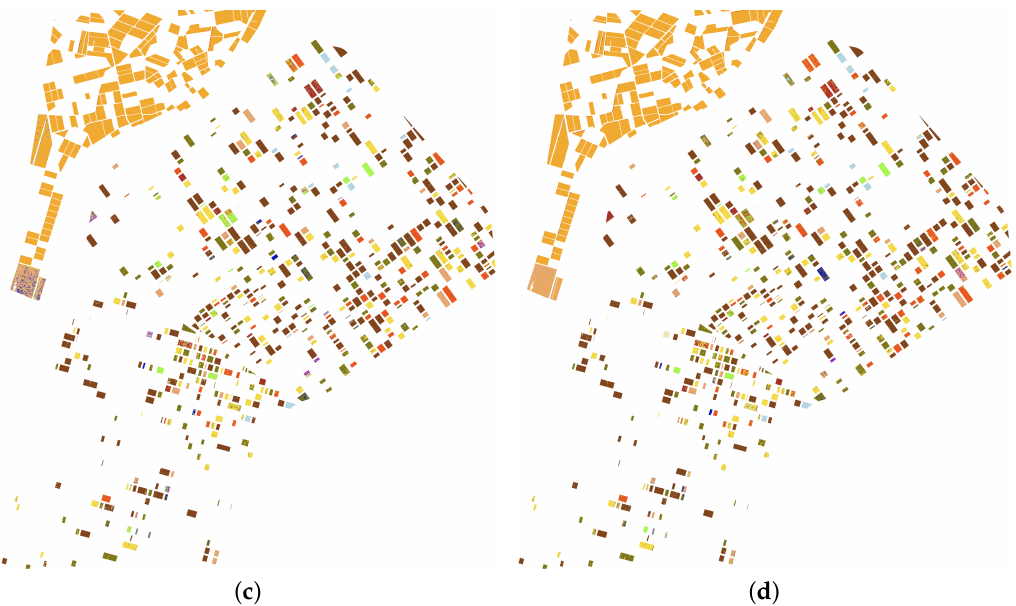
Figure 8. Maps with results of classification over the test areas. ( a ) Ground-truth data. ( b ) Crop-type map using only the polarimetric features: HH + VV + HHVV_Corr . ( c ) Crop-type map